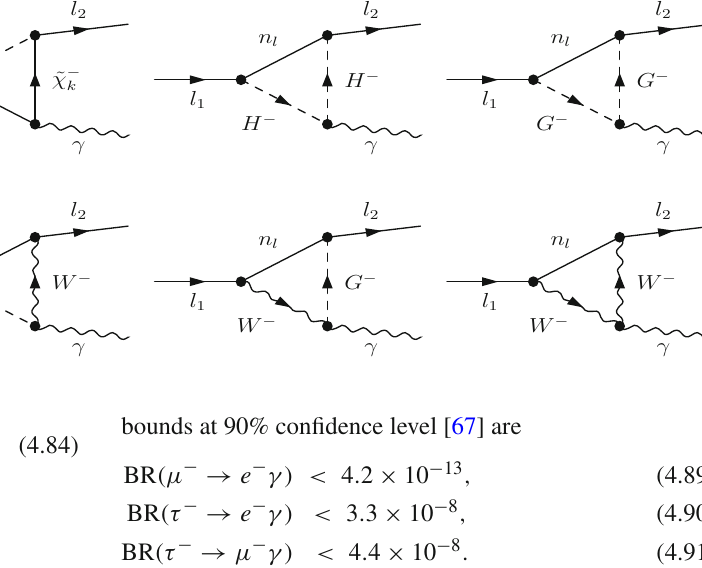
Fig. 3 Generic Feynman diagrams contributing to the charged lepton flavor-violating decays l 1 → l 2 + γ . The ranges of the indices are i = 1 ,..., 18 , k = 1 , 2 and l = 1 ,...,